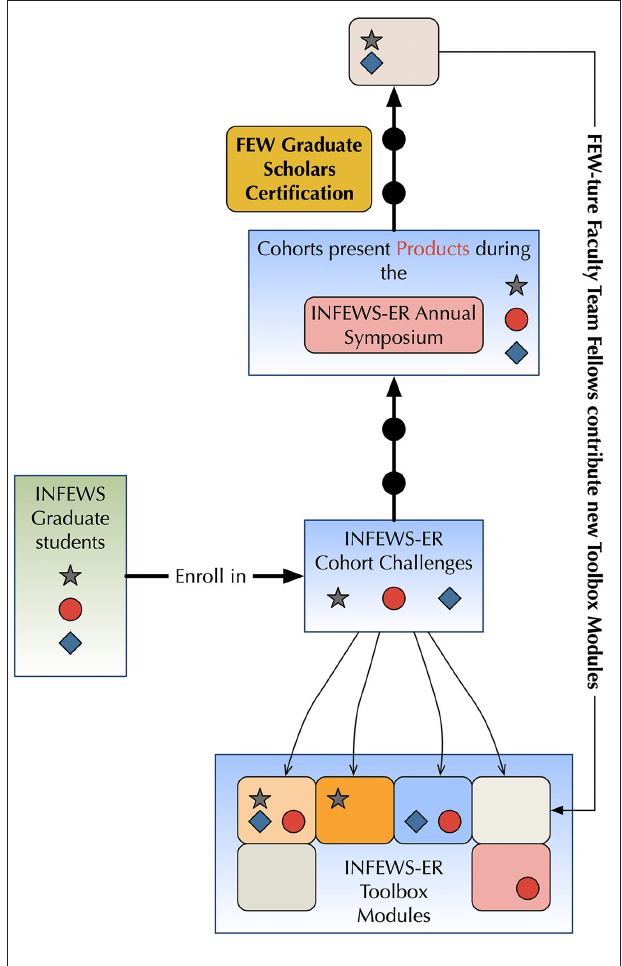
FIGURE 2 | Student participation in the INFEWS-ER. The curricula of the INFEWS-ER revolve around the Cohort Challenges. Students from multiple disciplines (represented by the symbols ) will enroll directly into open Challenges. Depending on the specifics of the cohort challenge, and their own mixture of disciplines, students will engage in a selection of Toolbox Modules. Working with a mentor, as indicated by the black dots ( (cid:8) ) they will work toward a product responding to their challenge, to be presented during the INFEWS-ER Annual Symposium. Students completing the challenge will be certified by the FEW Graduate Scholars Program. Students interested in continuing and documenting the response to their Cohort Challenge as a case study are invited to prepare a Toolbox Module and add it to the Virtual Resource Center. These students will be invited to join the FEW-ture Faculty Team